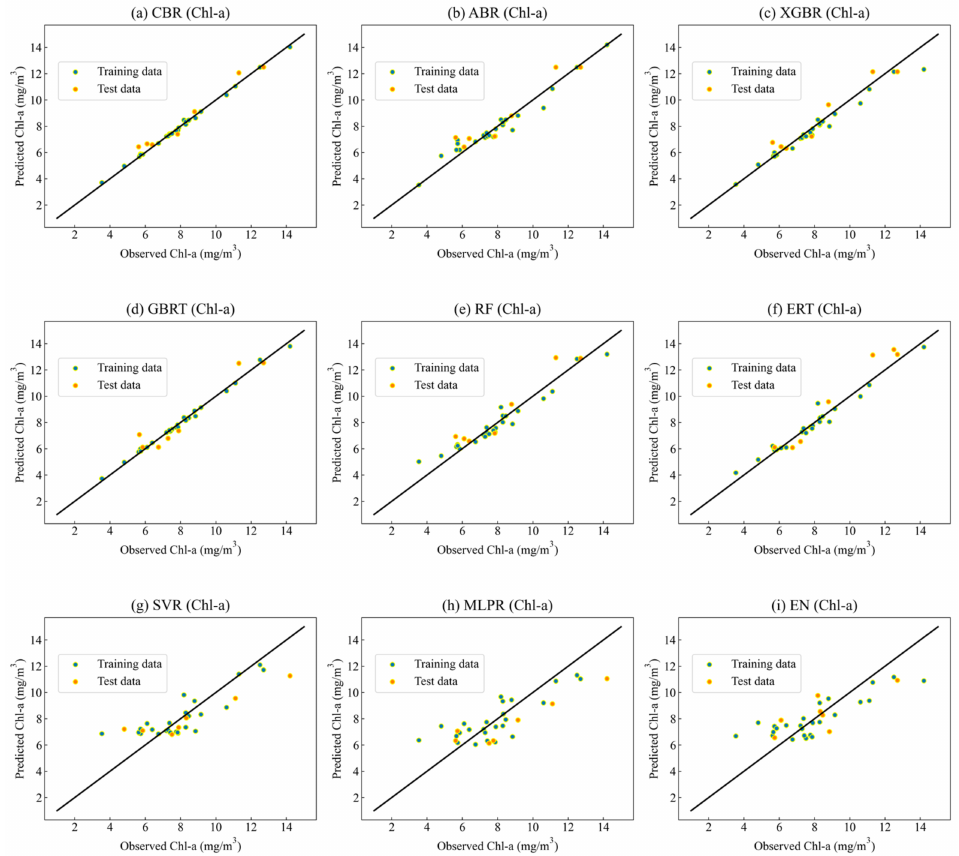
Figure 3. Scatter plot of the observed values and predicted values of Chl-a concentration (mg/m 3 ) using nine machine learning models including CBR, ABR, XGBR, GBRT, RF, ERT, SVR, MLPR, and